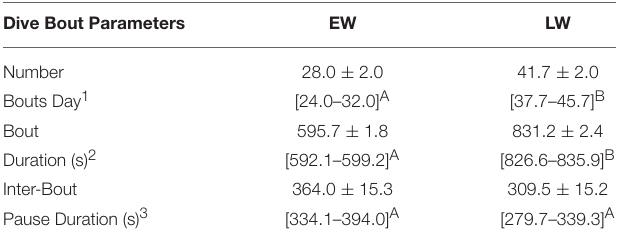
TABLE 1 | Dive bout characteristics for individual Common murres ( n = 17) during EW and